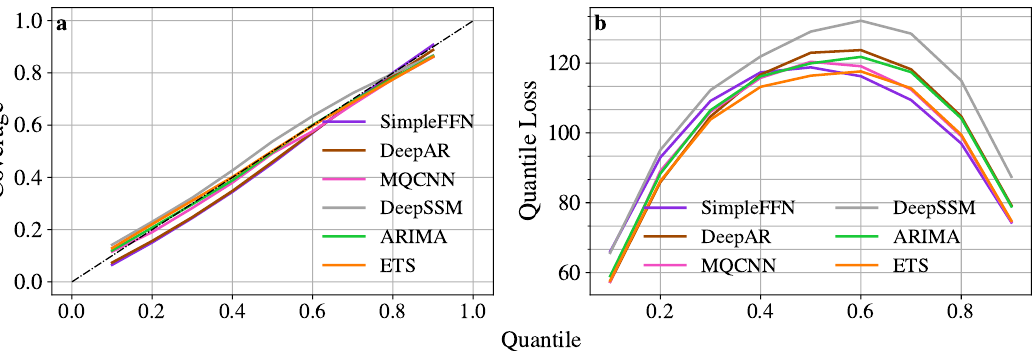
Figure 5. Quantile coverage and weighted quantile loss for probabilistic forecast algorithms. ( a ) Coverage indicates how much of the data is below the predicted quantile for the given level. The dashed blue diagonal represents the ideal scenario where observed quantile coverage exactly matches the nominal quantile levels. ( b ) Quantile loss is the pinball loss multiplied by 2, so that the 50th-percentile equivalents the total AE over the forecast horizon. Mean-averaging total AE over the forecast horizon ( H = 7) are equal to MAE error measures presented in Table 1. In this panel lower quantile loss indicates more accurate predictions. It shows which models are preferable for certain parts of the the probability distribution.